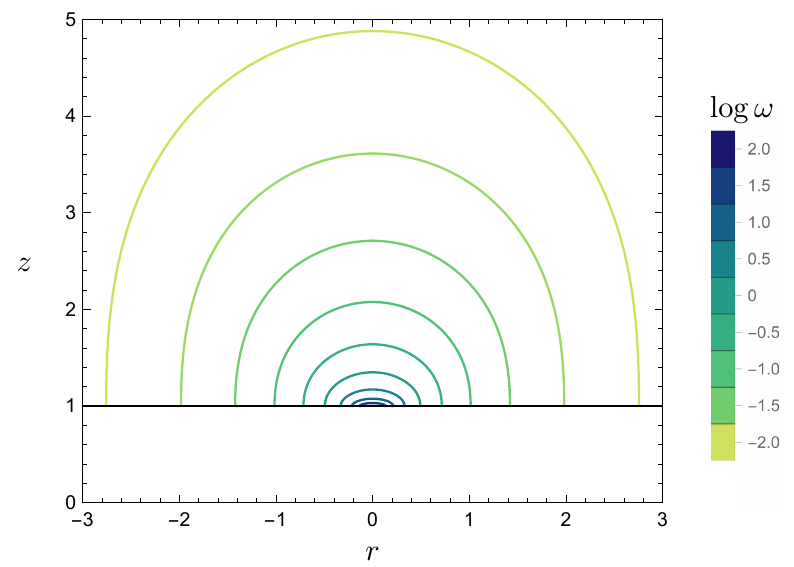
Figure 3 . Profile of rotating strings attached to a D-brane in AdS for small- ω /large- J (yellow) to large- ω /small- J (blue), in Poincaré coordinates z = e − ρ/R , attached to the brane located at z = 1